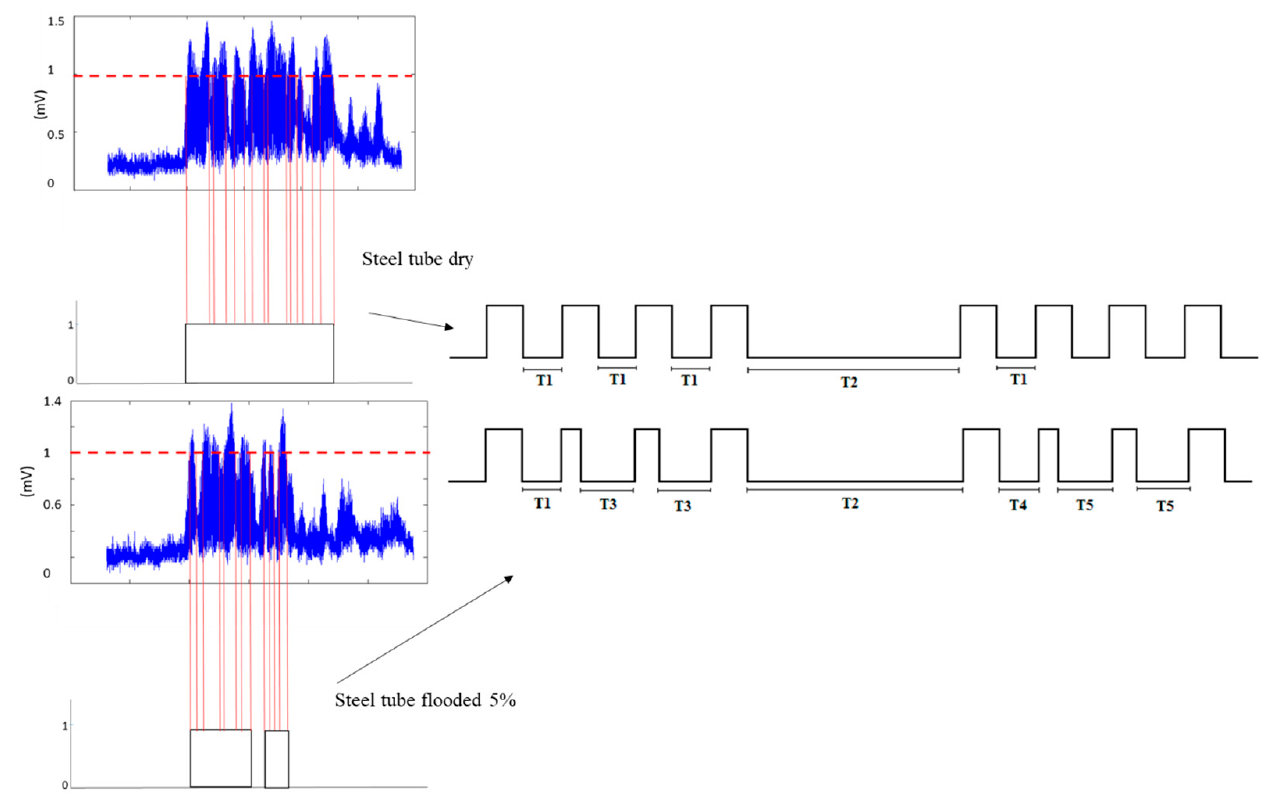
Figure 12. Guided wave analog pulses converted to digital pulses to estimate the TSBP; ( upper ), for a steel tube in dry conditions; ( lower ), for a steel tube flooded at 5% of its height. To increase the probability of detection, the number of train pulses incremented to 10, yielding an expected validation of 90 TSBPs. The DSP module computed signal averaging according to Equation (12) of the number of TSBP. The anticipated number of valid TSBPs was compared to the actual number of TSBPs acquired. In the dry condition on the steel tube, the number of valid TSBPs was 88 out of 90. Flooding the steel tube by 5% and